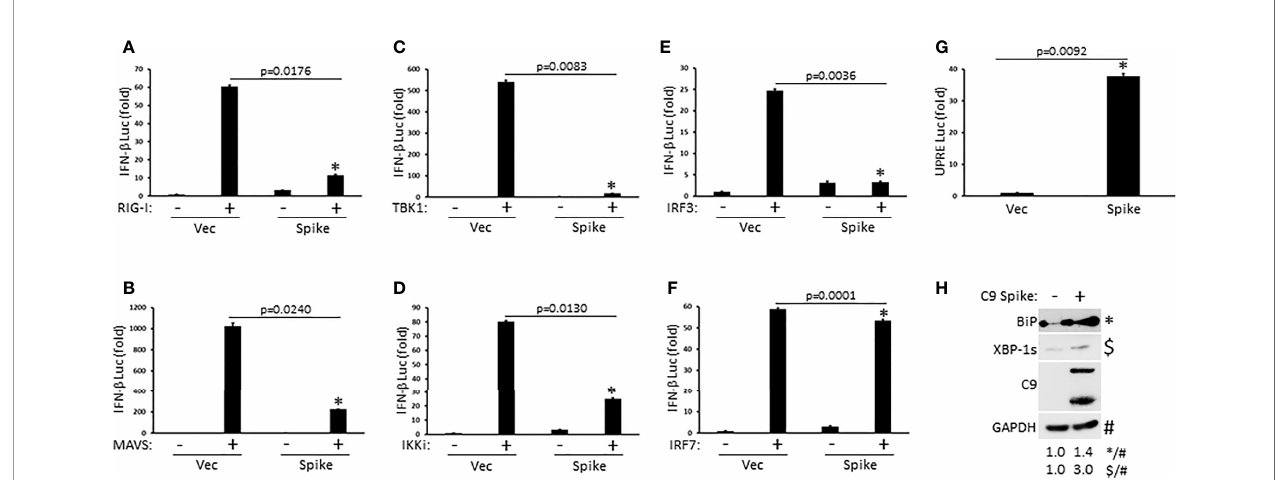
FIGURE 3 | SARS-CoV-2 Spike suppresses RIG-I mediated activation of IFN-I at the level of IRF3. (A – F) IFN- b luciferase reporter assays in HEK 293T cells co- transfected with plasmids encoding RIG-I (A) , MAVS (B) , TBK1 (C) , IKKi (D) , IRF3 (E) , IRF7 (F) (1 µg each) and C9 Spike (2 µg). (G) UPRE luciferase reporter assay in HEK 293T cells transfected with C9 Spike (2 µg). Data are means ± SEM of one experiment run in duplicate out of 2-3 independent experiments. *Indicates p < 0.05 as determined by the student ’ s t-test. (H) Immunoblot analysis of BiP and XBP-1s in HEK 293T cells transfected with C9 Spike (2 µg). GAPDH serves as a loading control. Results are representative of two independent experiments. The relative band intensity (*/#) of BiP and ($/#) XBP-1s in (H) was measured using ImageJ